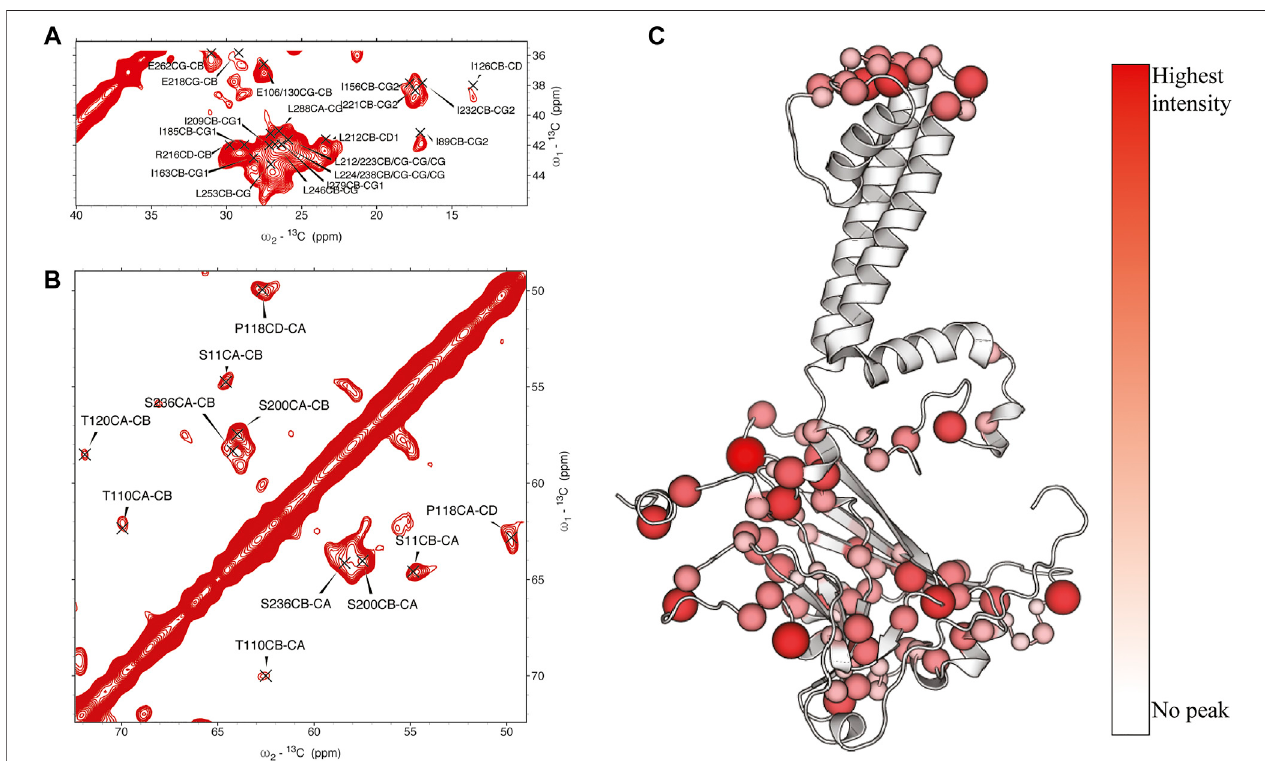
FIGURE 2 | (A, (B) assigned regions of 13 C- 13 C water-edited spectrum with 4 ms 1 H water - 1 H protein mixing, (C) position of assigned residues on the structure of KirBac1.1 with relative intensity represented in color and size of